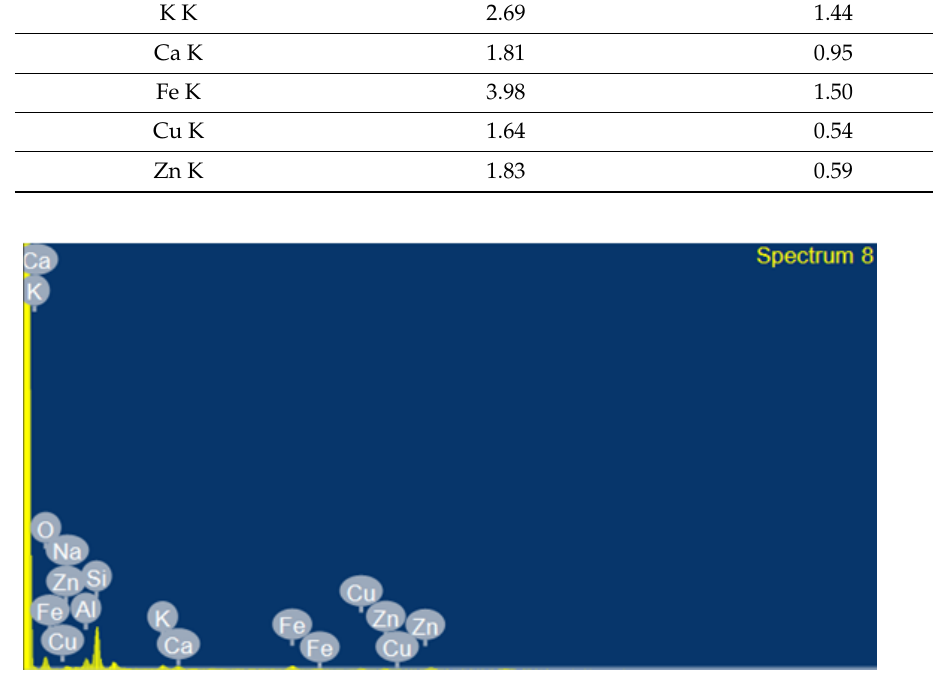
Figure 3. EDX analysis of VA.